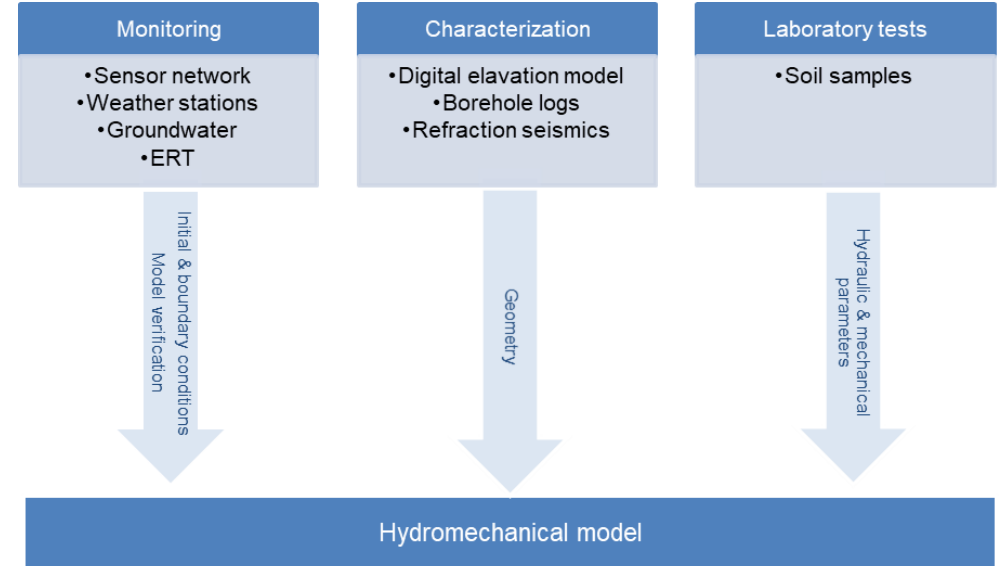
Figure 6. Schematic sketch of the different input streams into the hydromechanical model for stability